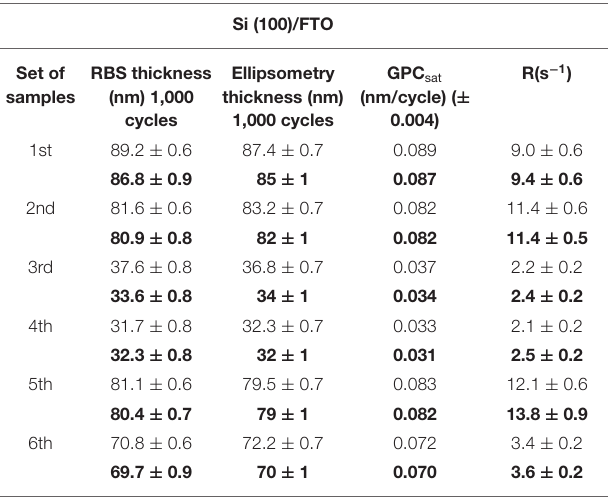
TABLE 2 | RBS and ellipsometry thickness, growth per cycle saturated, and molecular flux. Si (100)/FTO Set of RBS thickness samples (nm)